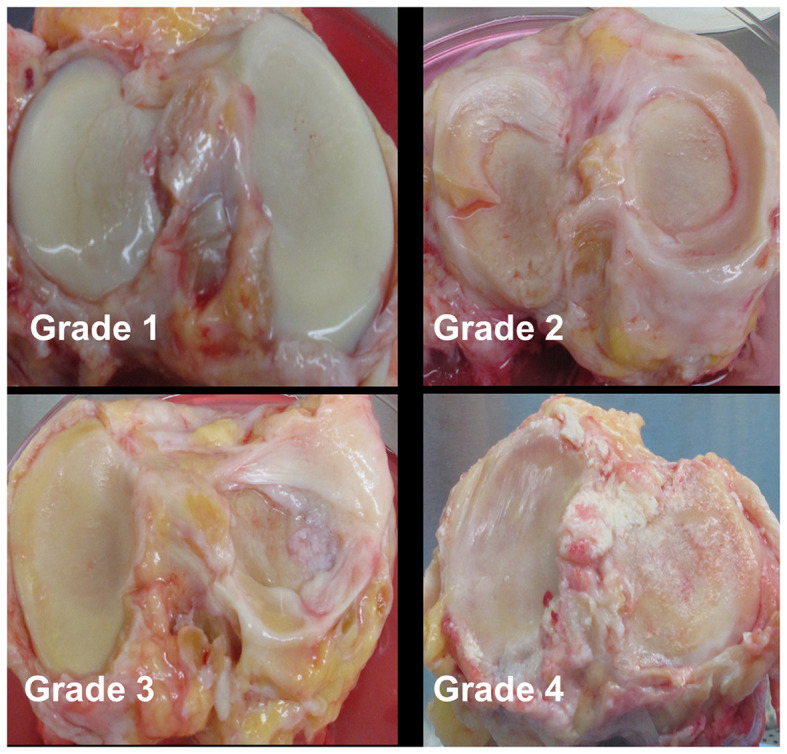
Representative gross morphology of donor knees. Grade 1–4 represent modified Collins grade as follows: Grade 1 = limited disruption of the articular surface with only minor fibrillations; Grade 2 = fibrillation of cartilage with fissures ± small osteophytes; Grade 3 = osteophytes + cartilage fibrillation and fissuring with 30% or less of the cartilage surface eroded down to subchondral bone; Grade 4 = osteophytes and gross geometric bony change + >30% of the cartilage surface eroded down to the subchondral bone.